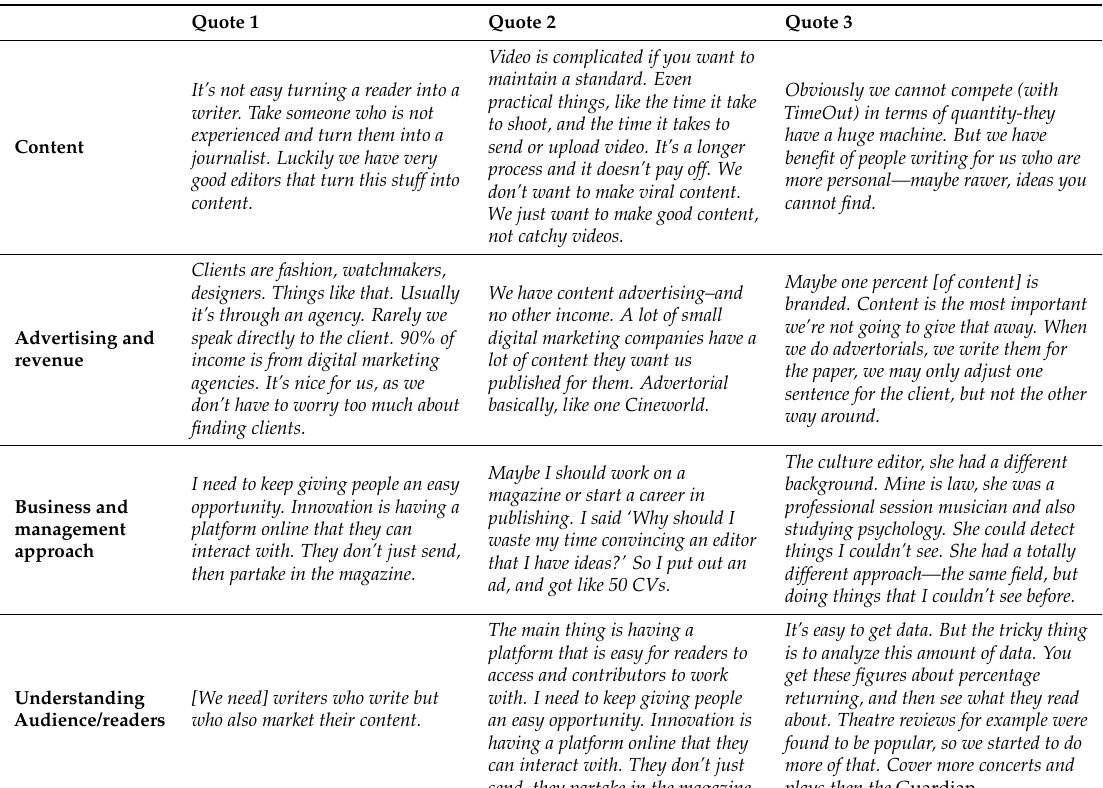
Table 1. Case Study: The